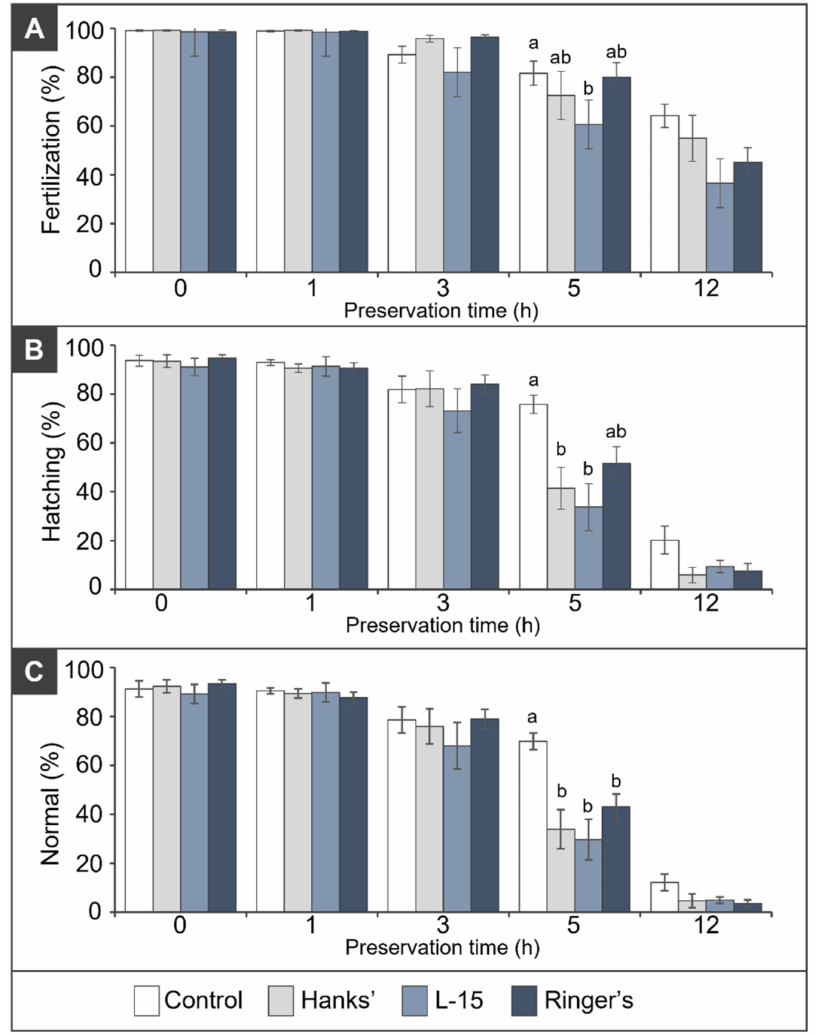
Figure 1. Developmental efficiency after preservation of ovulated eggs of kawakawa Euthynnus affinis in different solutions. ( A ) Fertilization rate, ( B ) hatching rate and ( C ) normal developed larvae rate (normal rate) after preservation of ovulated eggs in Hanks’ solution, L-15 medium and Ringer’s solution, and without artificial medium (control) for 0, 1, 3, 5, and 12 h at 20 ◦ C. Different superscript letters indicate significant differences determined by the Steel–Dwass test ( p < 0.05). There is a significant difference between “a” and “b”. There is no significant difference between “a” and “ab” or “b” and